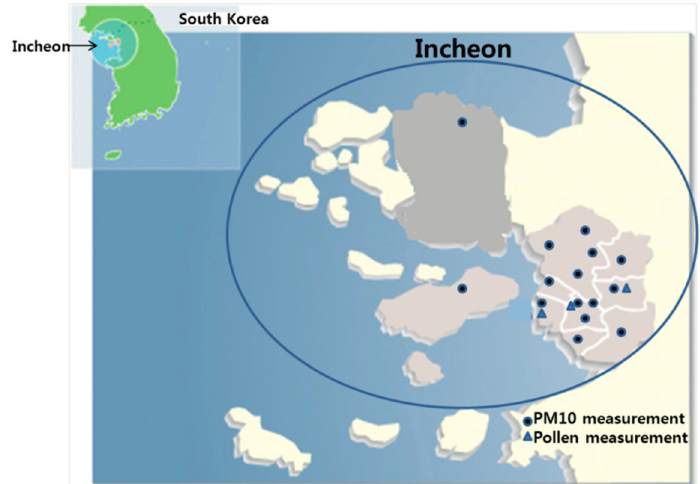
Figure 1. Map of the monitoring station locations and basic area features. Circle: PM 10 measurement area, Triangle: pollen measurement